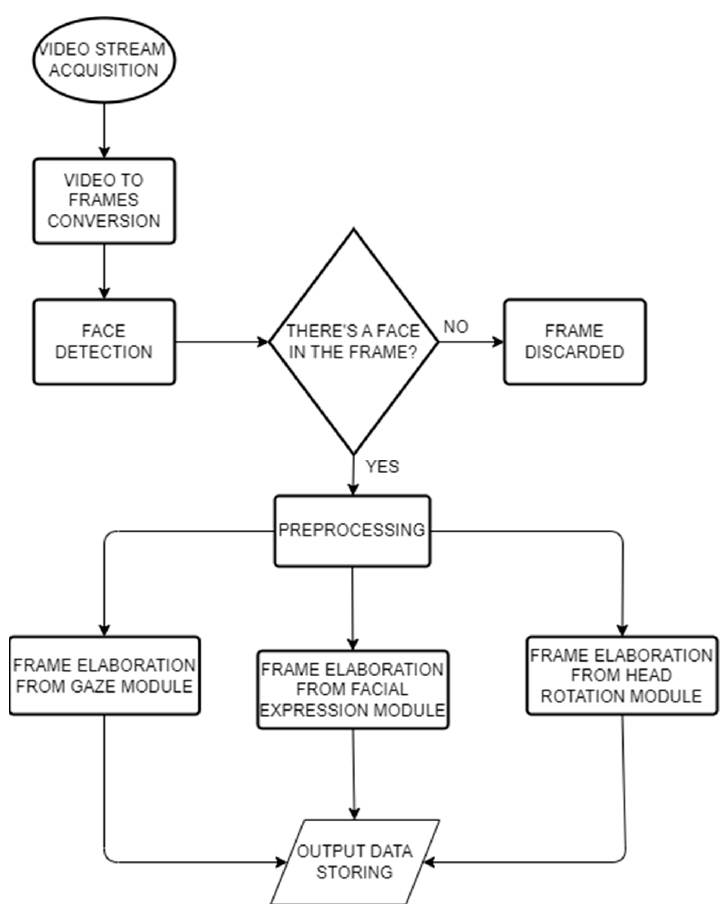
Figure 2. Flow chart showing the frame collection and processing.